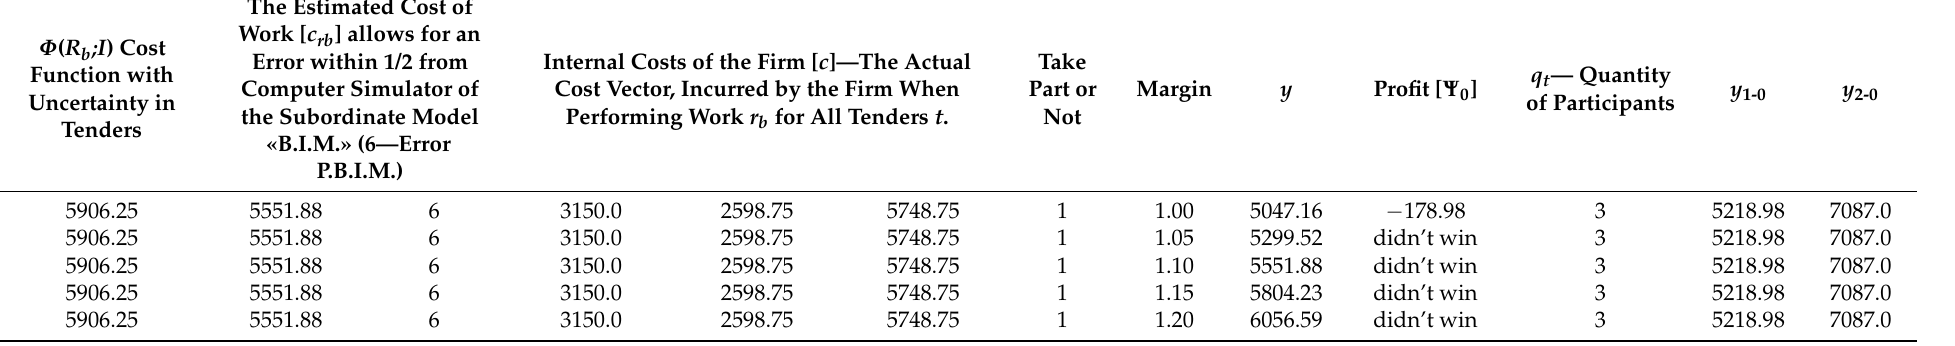
Table 2. Fragment of the spreadsheet list “Subordinate Model P.B.I.M.”.